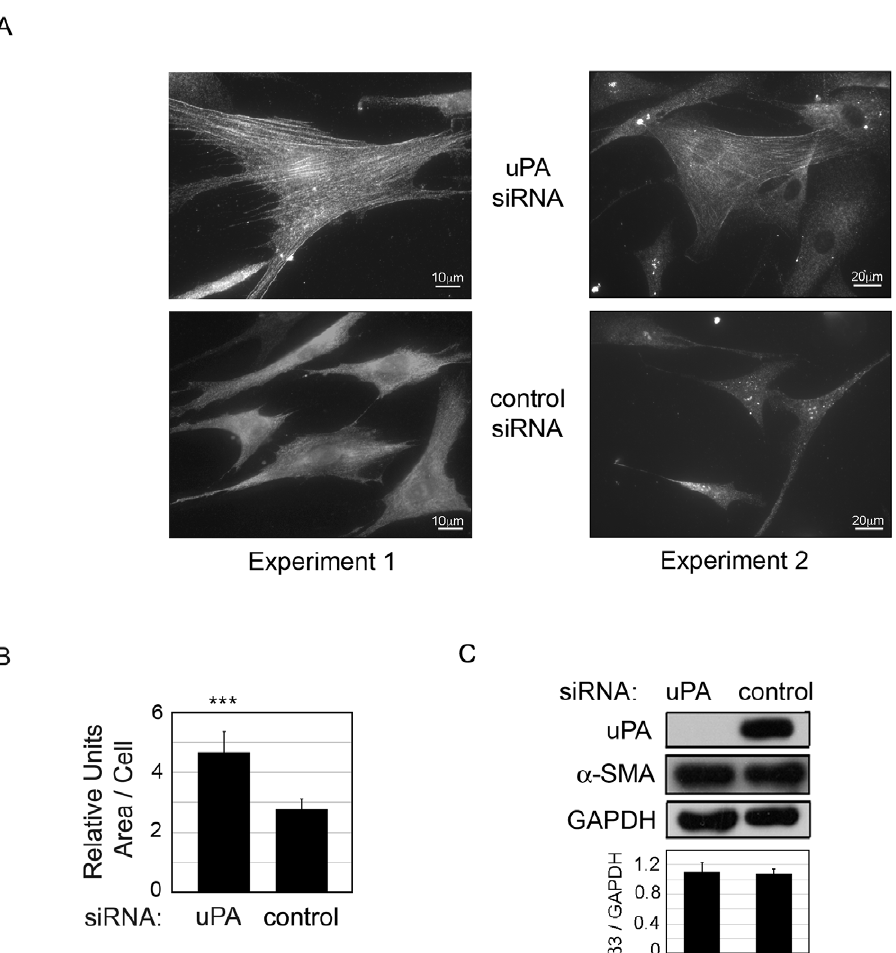
Figure 4. siRNA knockdown of uPA triggers incorporation of a -SMA into stress fibers. HCF were transfected with siRNA against uPA or control siRNA and after 24 hours (A) cells were immunostained for a -SMA. Bar=10 um or 20 um. Images are from two independent experiments. (B) Metamorph analysis quantified changes in average cell size in each condition. ***p value , 0.001. (C) Cell lysates were Western blotted for a -SMA and for uPA to confirm knock down. GAPDH indicates equal loading. Densitometry for a -SMA/GAPDH is shown. N=3–5 for each